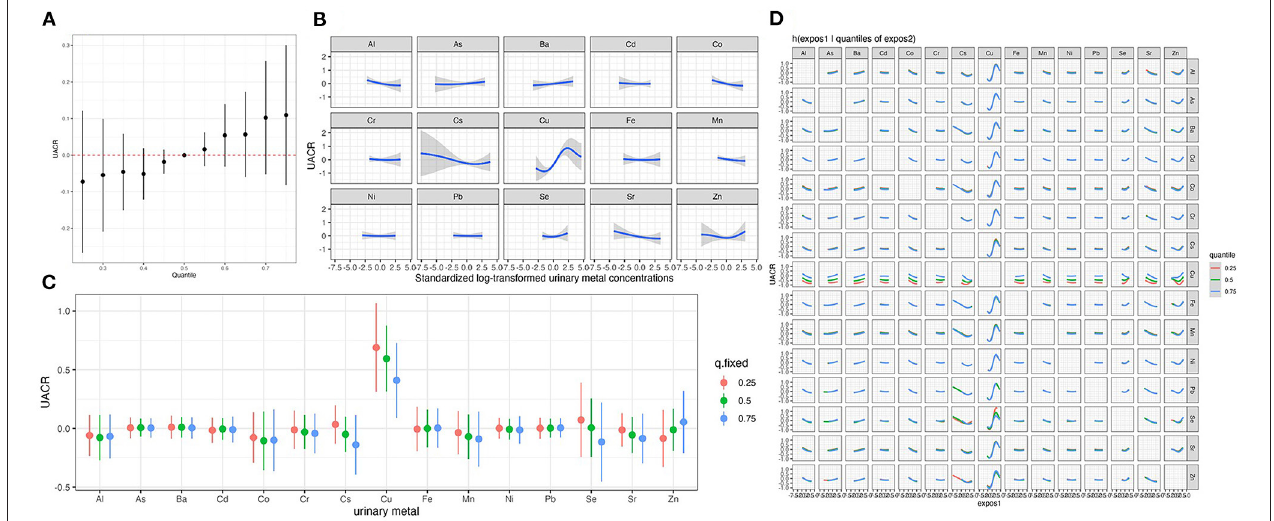
FIGURE 2 | Joint effect of the urinary metal and metalloid mixture on UACR by Bayesian Kernel Machine Regression a . (A) Overall associations between the urinary metal and metalloid mixtures and UACR. (B) Univariate exposure-response curves for individual metal. (C) The single-exposure effect of each metal. (D) Bivariate exposure response functions for each of the urinary metal and metalloid. a The Model was adjusted for age, sex, BMI, education levels, smoking status, drinking status, hypertension and